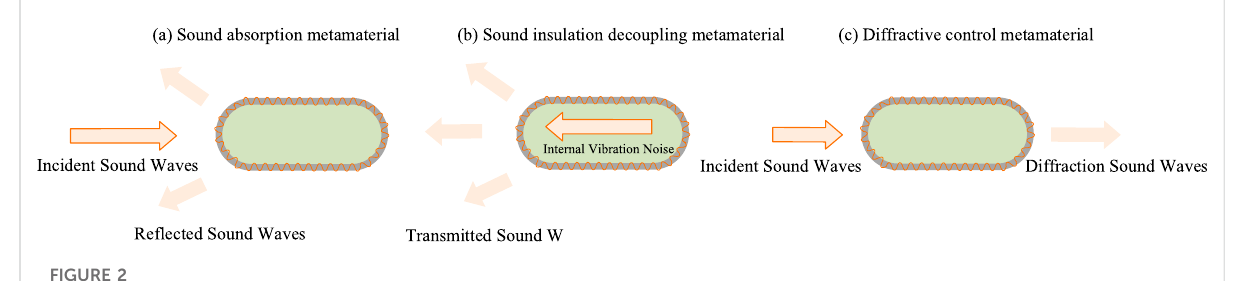
Sketch of development history of acoustic metamaterials.